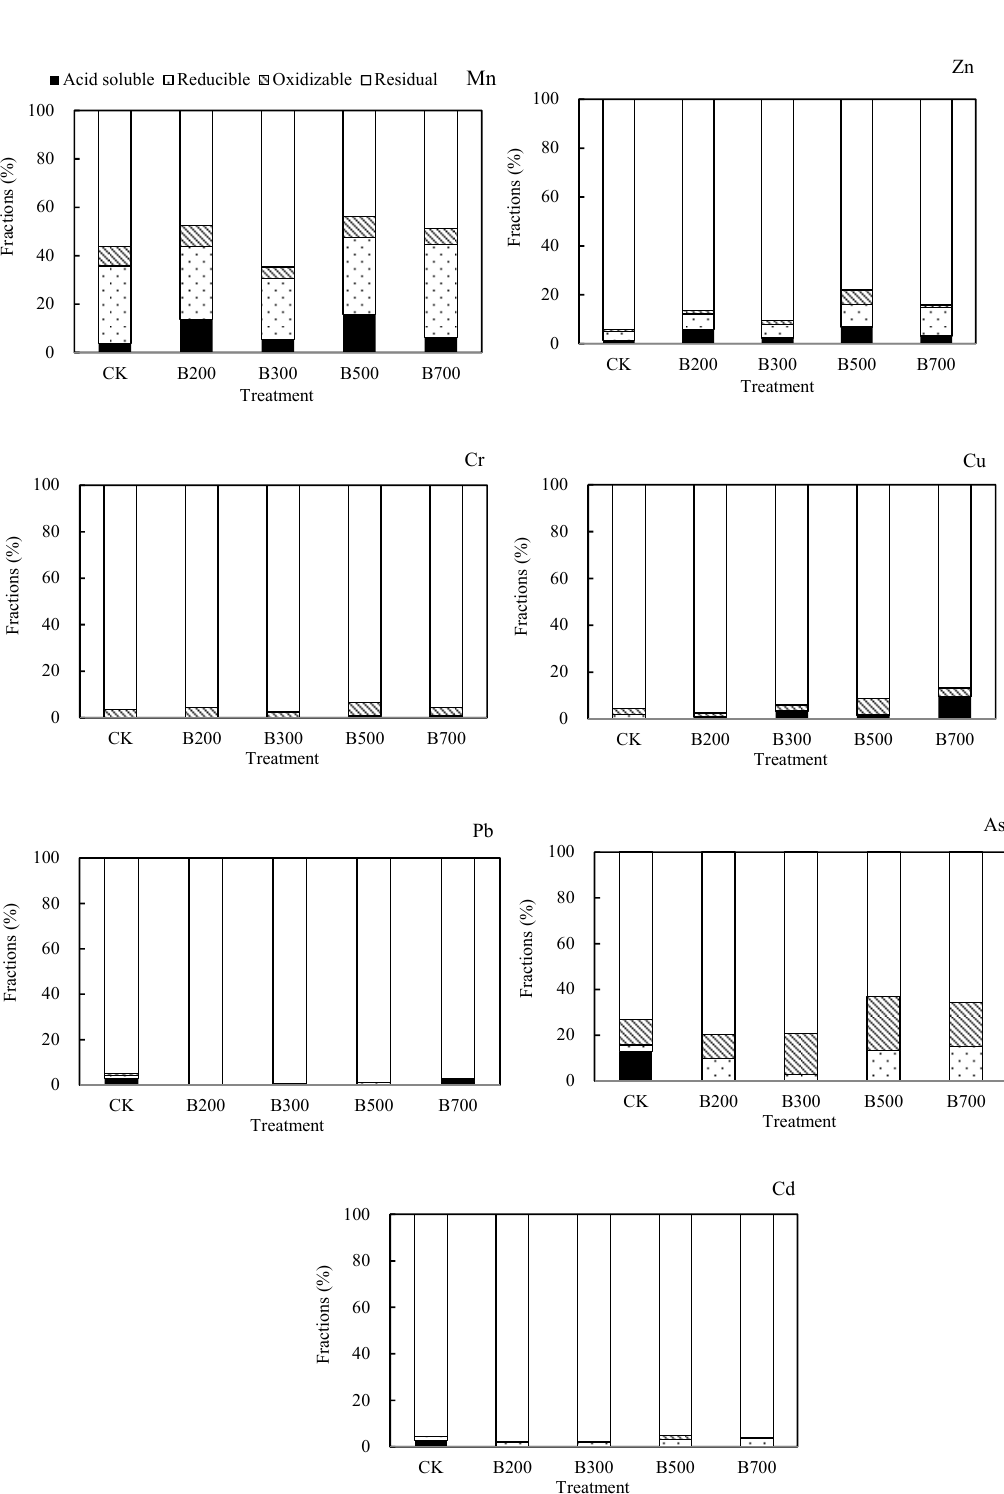
Figure 1. The percentages of different fractions in total amount of heavy metals in the soils amended with the biochars derived from municipal sewage sludge at 200 °C, 300 °C, 500 °C, and 700 °C for 2 h in a muffle furnace and then grown turf grass.